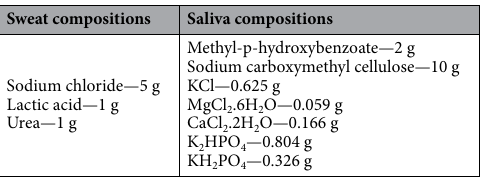
Table 4. Chemical compositions of artificially simulated sweat and saliva bio-mimic solutions (per